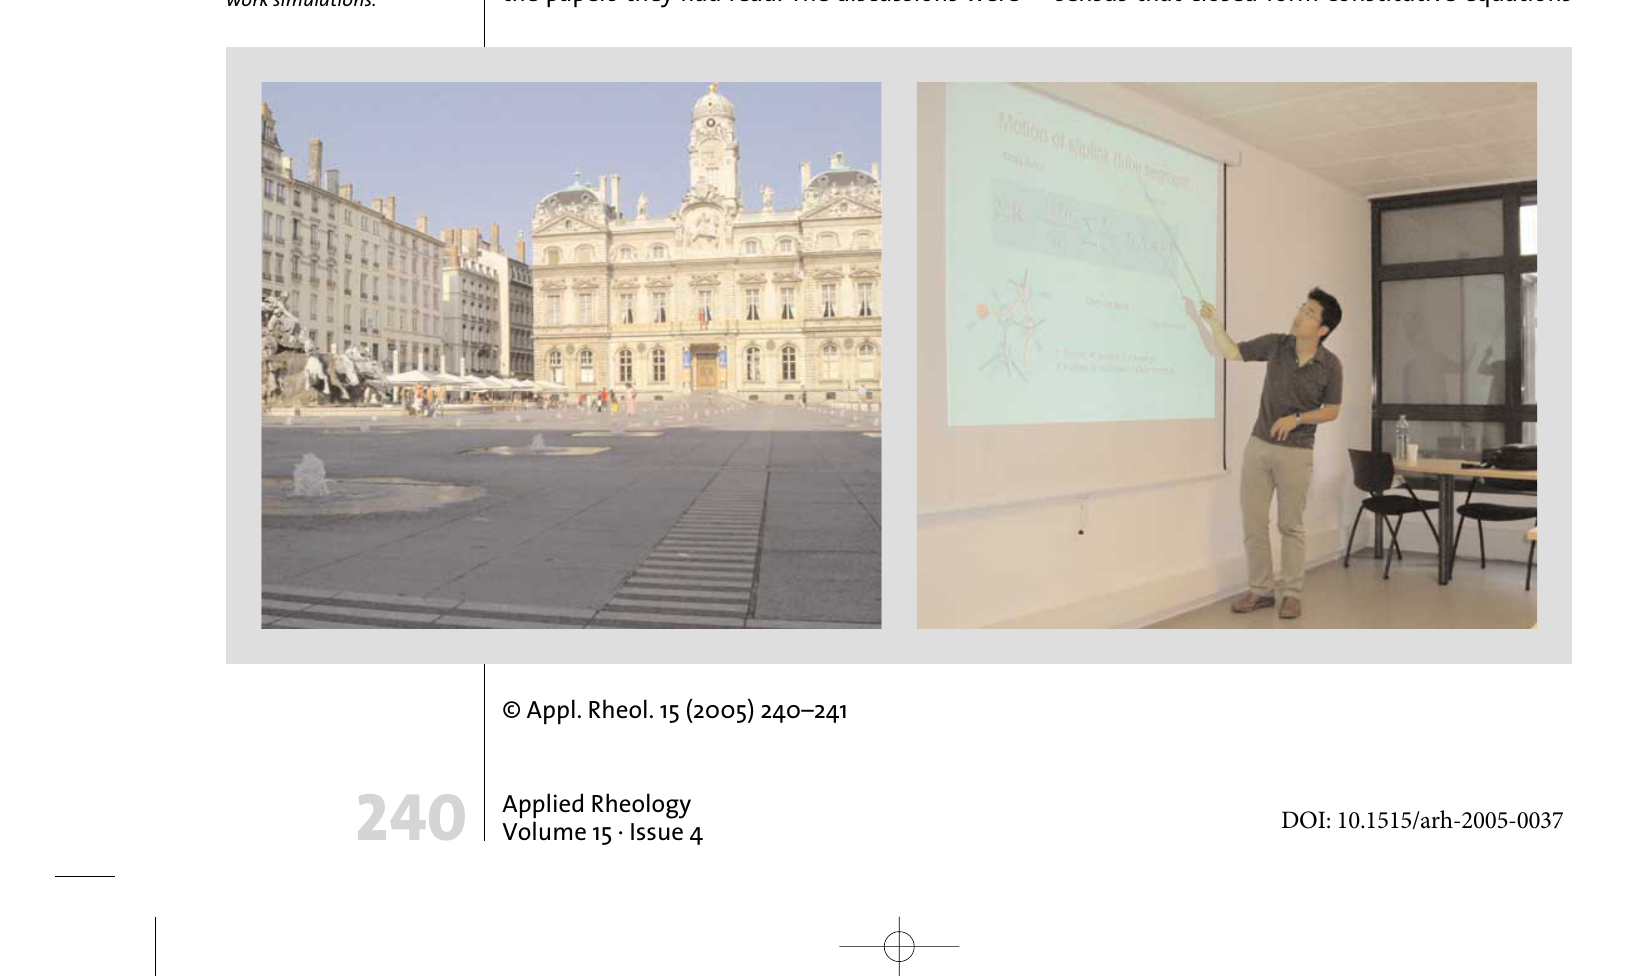
Figure 1 (left): CECAM is situated in Lyon, which is a city with a nice old city center many big squares and a good collection of first class restaurants. Figure 2: Yuichi Masubuchi present- ing his workshop contribu- tion on primitive chain net- work